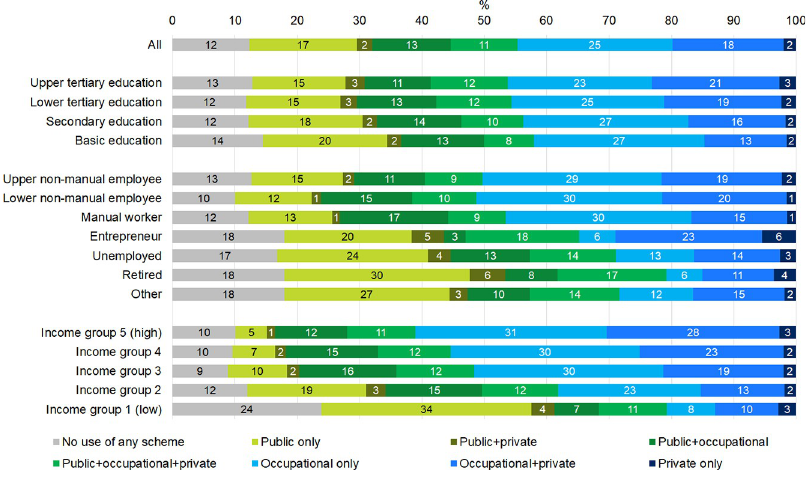
Fig 4. Average adjusted predictions from multinomial logit models of users of primary outpatient health care schemes during year among women 2013 according to socioeconomic variables. Residents of Oulu, Finland, women aged 25–64 in 2013 (N = 45